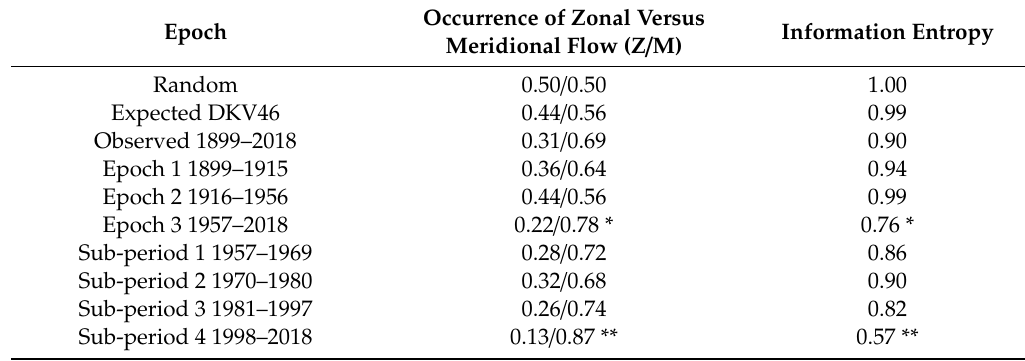
Table 3. The distribution and Shannon or Information Entropy for NH flow epochs studied here. Zonal flow is Type 1 + Type 2 and Meridional is Type 3 + Type 4. Bold values are significant at the 90% confidence level, while a * (**) indicates significance at the 95% confidence level using the Kolmogoro–Smirnov test, where DKV46 serves as the expected